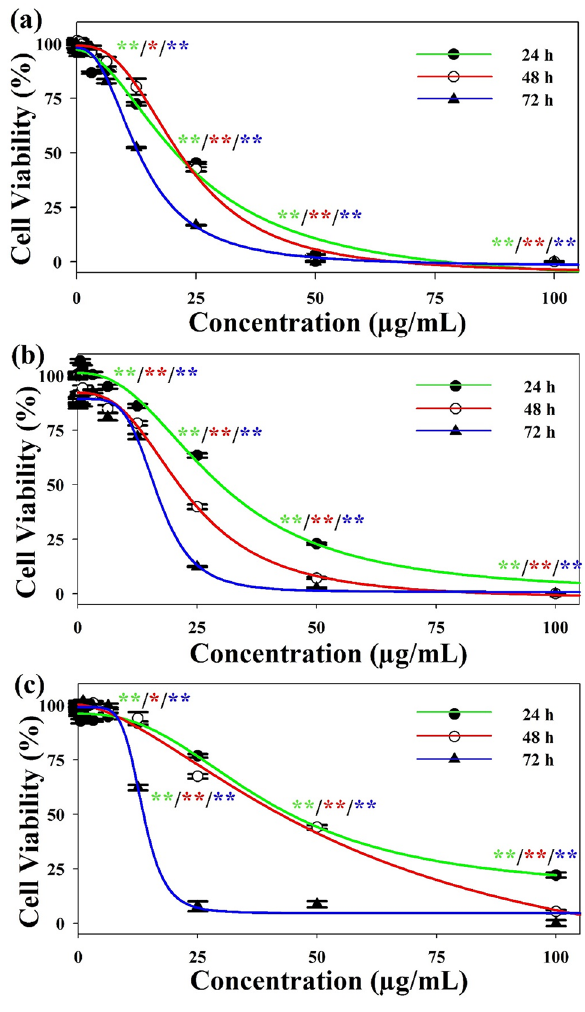
Figure 2. Viability of H1299 ( a ), MCF-7 ( b ), and SK-HEP-1 ( c ) cells following treatment with varying concentrations (0–100 µg/mL) of fraction R-S5-C1-H1 for 24 h, 48 h, and 72 h. Values are expressed as mean ± SEM of three independent experiments; differences were considered significant at p ≤ 0.05 (*) and p ≤ 0.001 (**).